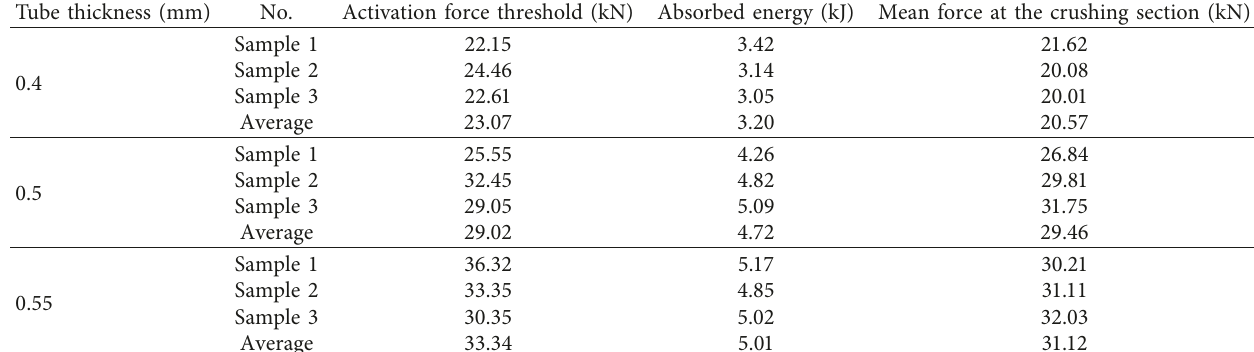
Table 4: Main mechanical parameters of the symmetric tube-crushing dissipators at static tests.